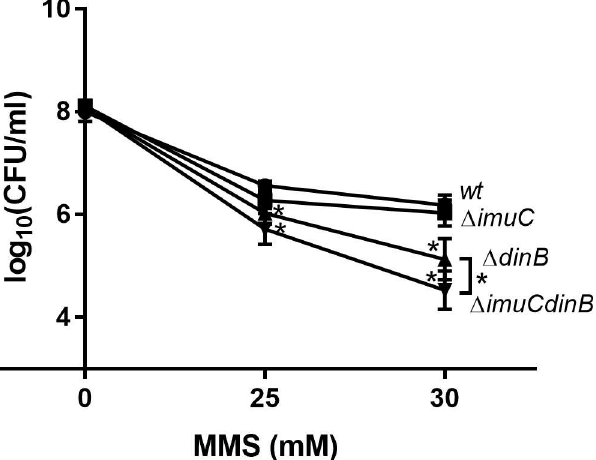
Fig 2. Survival of exponentially growing P . putida TLS polymerase-deficient cells after MMS treatment. Survival was estimated at different concentrations of MMS after 45-mintreatment period. Data represents the mean ( ± 95%CI)values of three independentexperiments performed in triplicate. ( ● ) wild-type; ( ■ ) Δ imuC ;( ▲ ) Δ dinB ;( ▼ ) Δ imuCdinB . Asterisks indicate statistically significantdifference ( P < 0.05; two-way ANOVA followedby Tukey’s multiple comparison post hoc test) in sensitivity betweenthe mutant and the wild- type strain, and betweenthe Δ dinB and the Δ imuCdinB